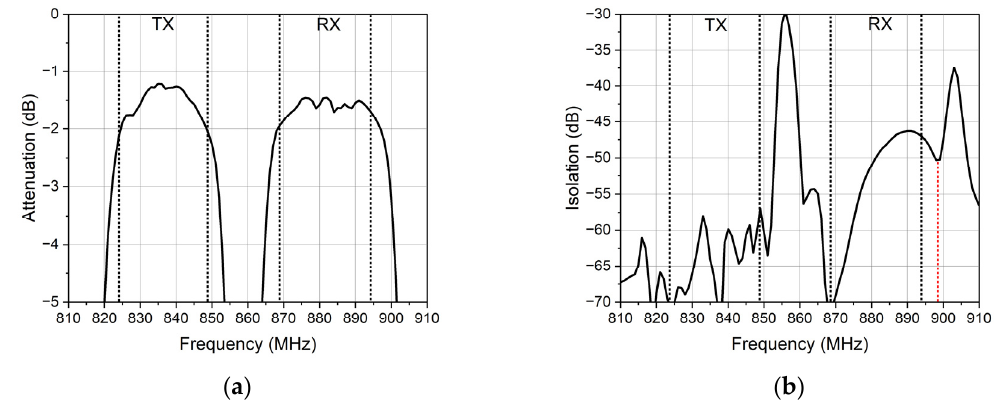
Figure 2. The simulation characteristics of the duplexer. ( a ) The insertion loss of the duplexer. ( b ) The isolation of the duplexer.